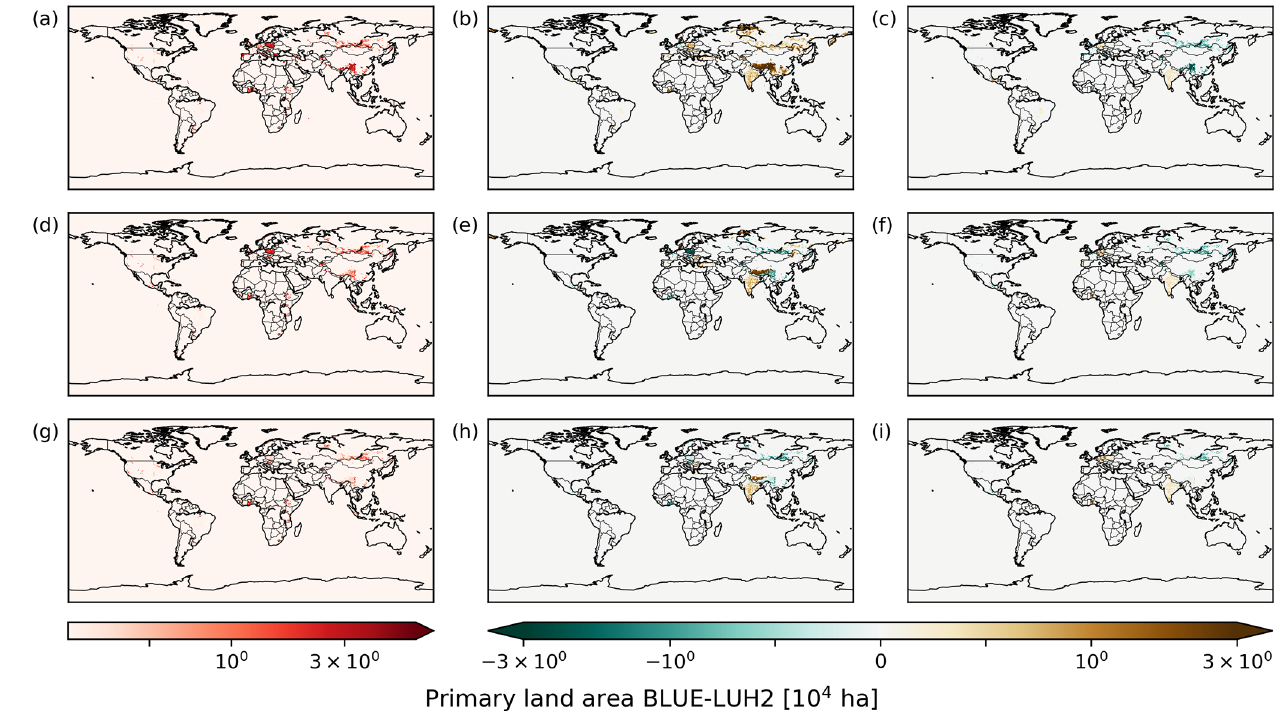
Figure A5. Differences in primary land area in BLUE and LUH2 in 2014 for REG850 (a) , REG1700 (d) and REG1850 (g) . Differences HI-REG (b, e, h) and LO-REG (c, f, i) of BLUE-LUH2 primary land area for the same years as in panels (a, d, g) . The global area of primary land in 2014 is 3 . 6 × 10 9